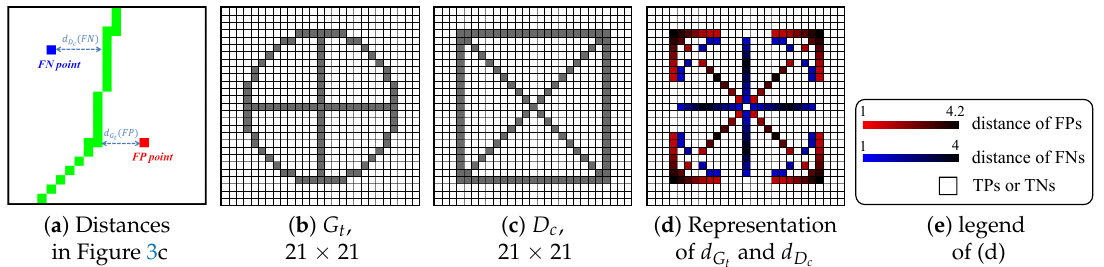
Figure 9. Example of ground truth ( G t ) versus (vs.) a desired contour ( D c